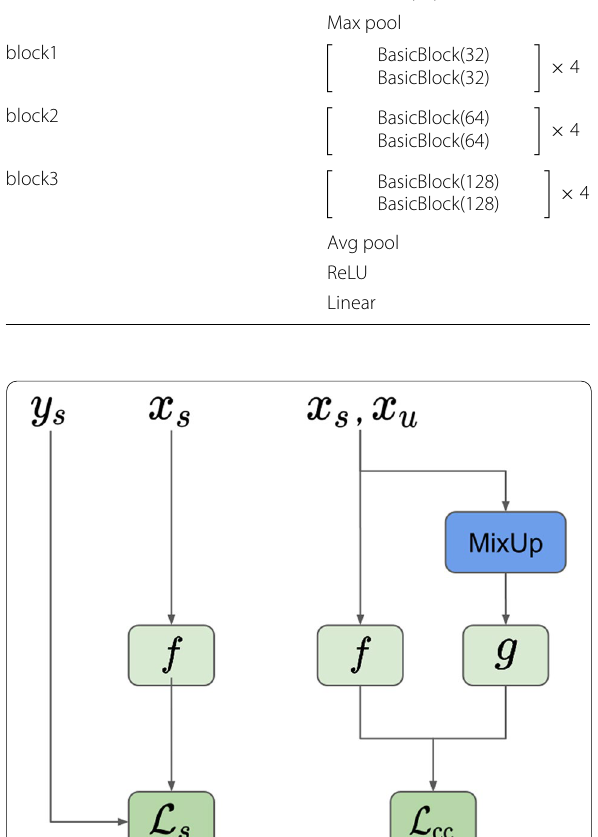
Fig. 1 MT workflow. Both models receive as input labeled x s and unlabeled files x u . A supervised loss L s is computed between the ground truth and the student model predictions, whereas a consistency cost L cc is computed between the student and teacher model